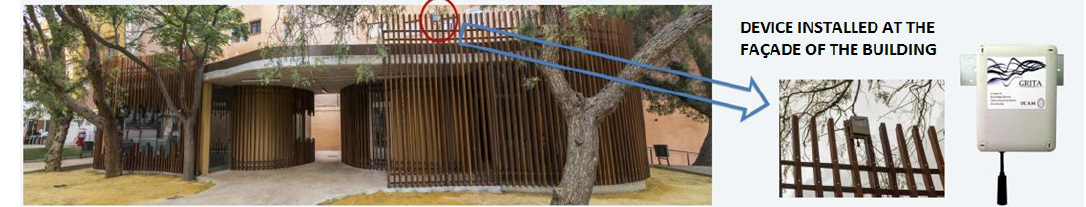
Figure 9. Photography of the multi-purpose room where the devices are installed. A close-up of the outdoor device is shown. Inside of the building there are the gateway, the server and the indoor acoustic